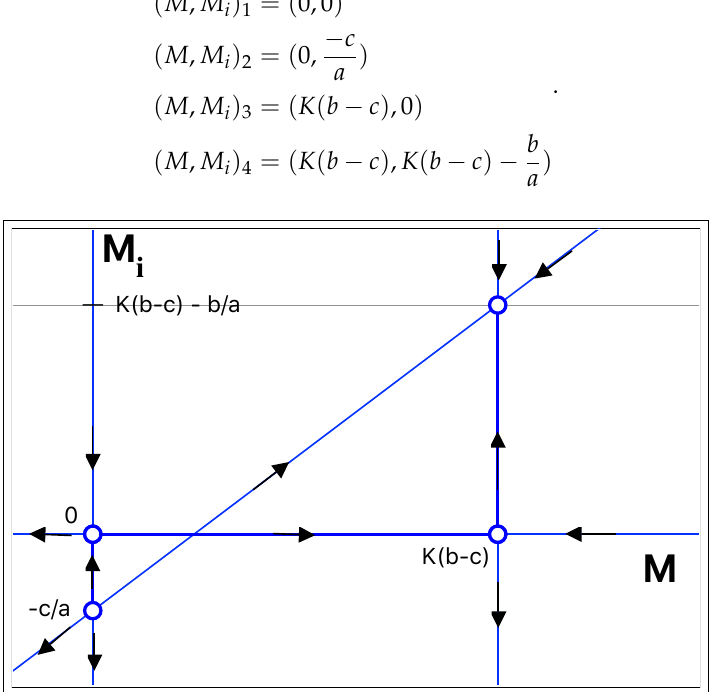
Figure 1. Nullclines in phase space. Their intersection defines the four fixed points of the system. The arrows indicate the stable and unstable manifold corresponding to each fixed point. The parameters were chosen such that the fixed point with a positive number of infected mice is stable. The fixed points (0,0) and [ K ( b − c ) ,0] are both saddle